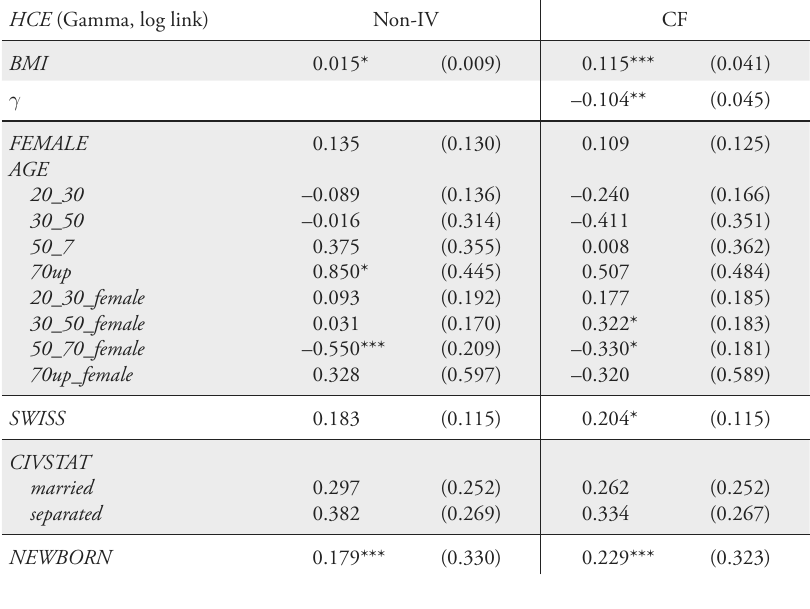
Table 8: Complete Output from the Cost